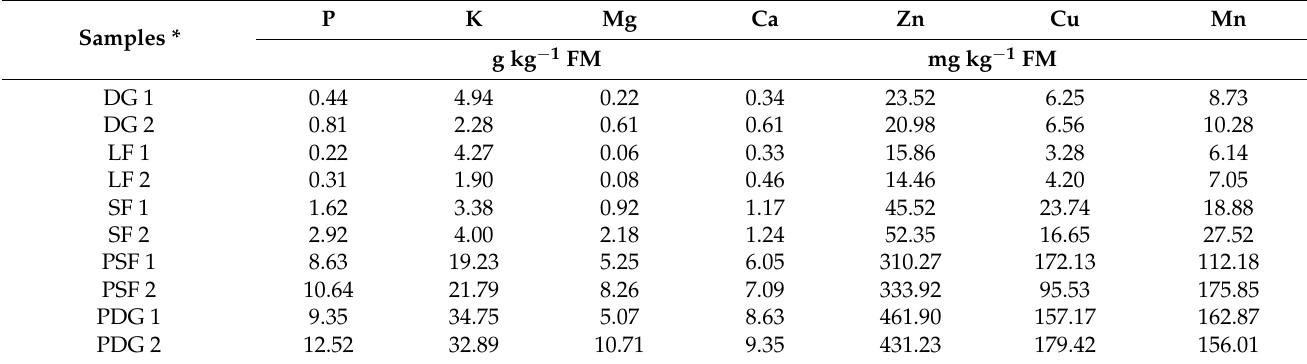
Table 3. Content of macronutrients and heavy metals in the samples.